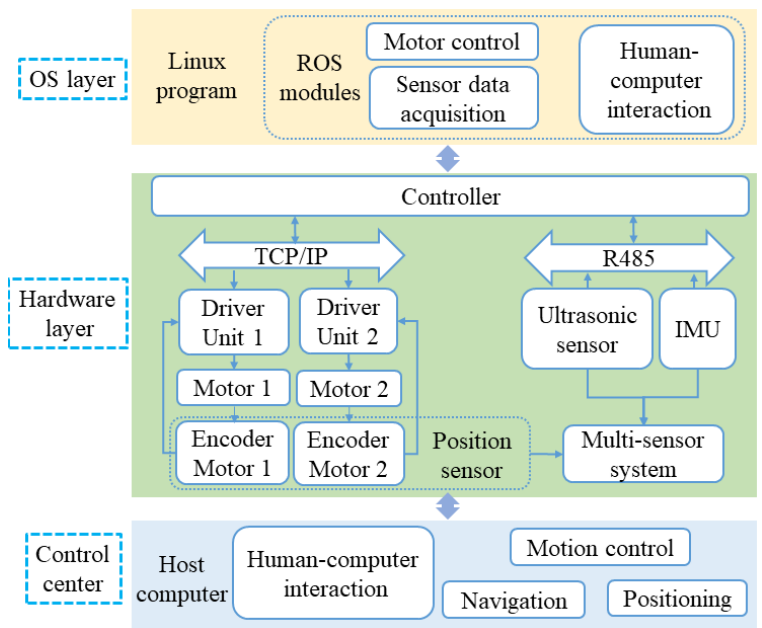
Figure 6. System architecture of WMR